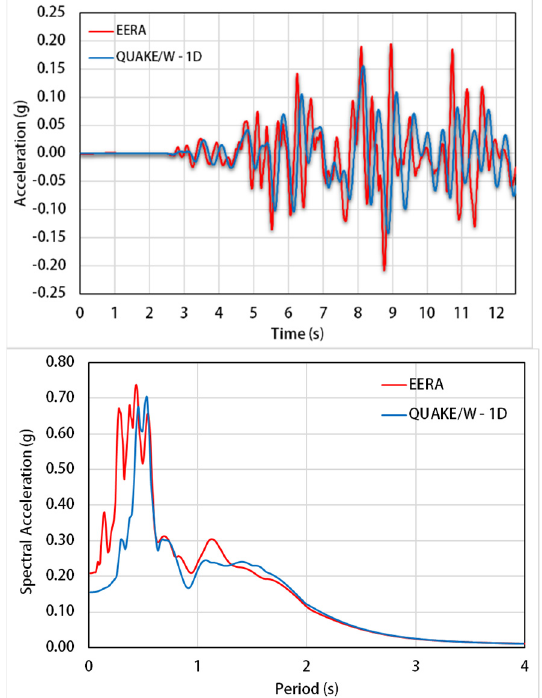
Figure 13. Comparison between 1-D analyses performed by Equivalent-Linear Earthquake Site Response Analysis (EERA) and QUAKE/W for point 1, in terms of acceleration time history and spectral acceleration, for the Amoruso et al. [26] input.